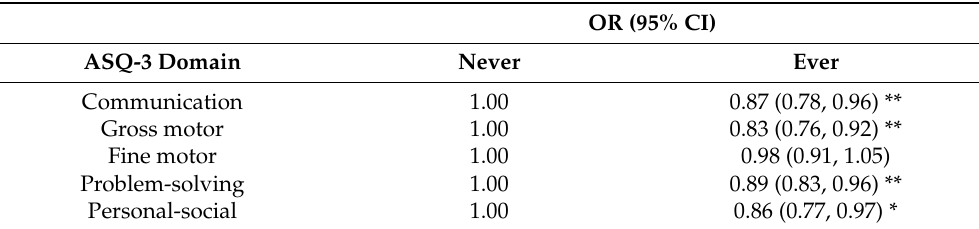
Table 3. Child development delays at 3 years of age in association with “never” and “ever” family dog ownership.